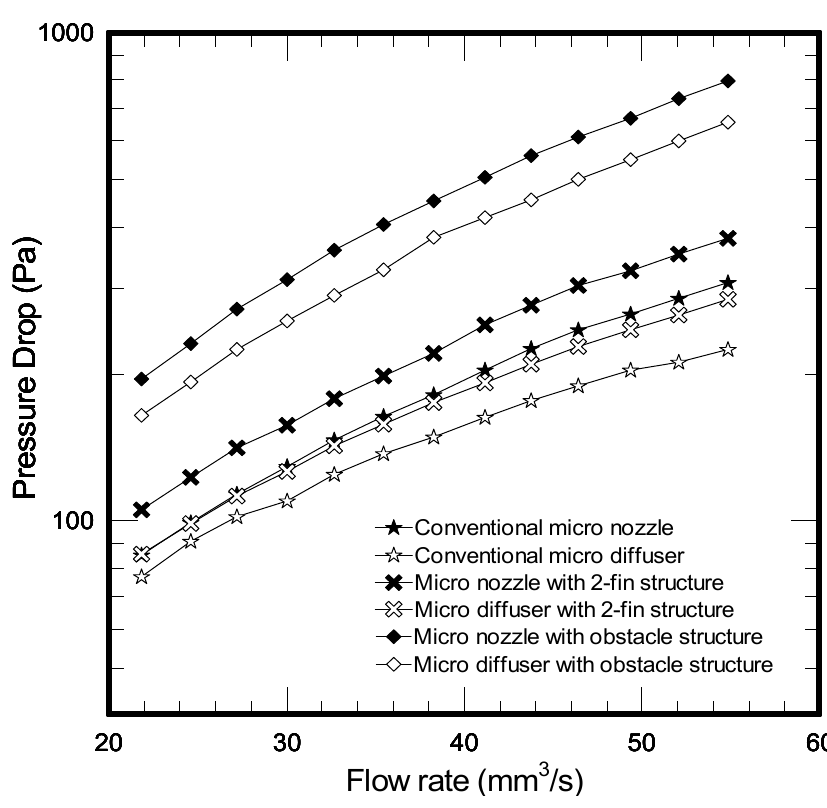
Figure 2. Flow rate vs . pressure drop for micro